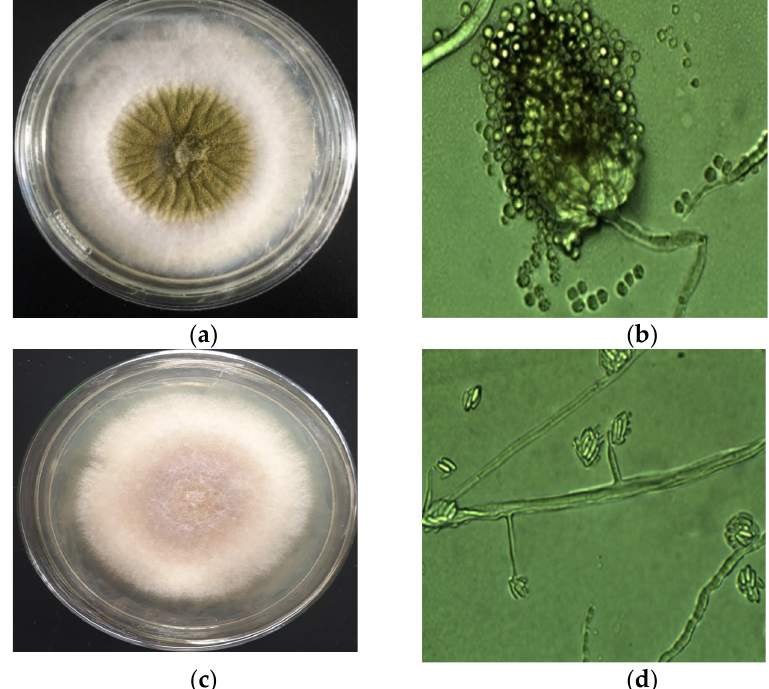
Figure 2. A. flavus on PDA ( a ), microscope ( b ), and F. proliferatum on PDA medium ( c ) and micro- scope ( d ).